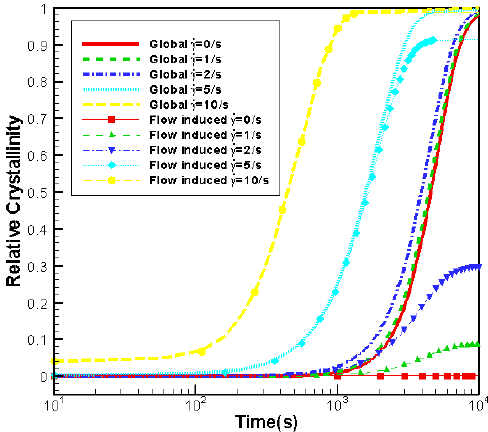
Figure 5. Relative crystallinity comparison with different shear rates.